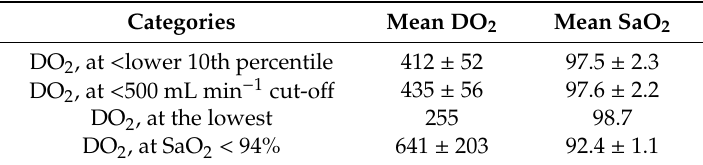
Table 3. Relationship between DO 2 and SaO 2.